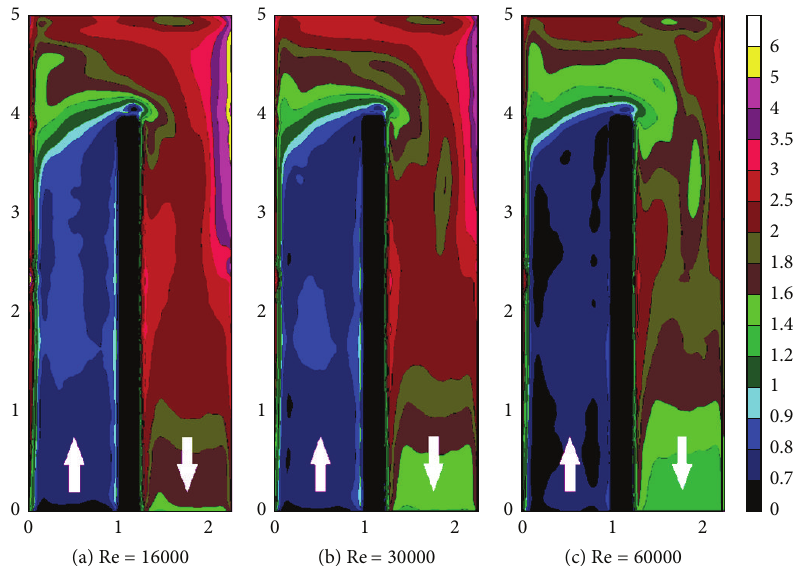
Figure 8: Normalised Nusselt number Nu / Nu ∗ , distribution for the smooth channel. Adapted from Astarita and Cardone [10].